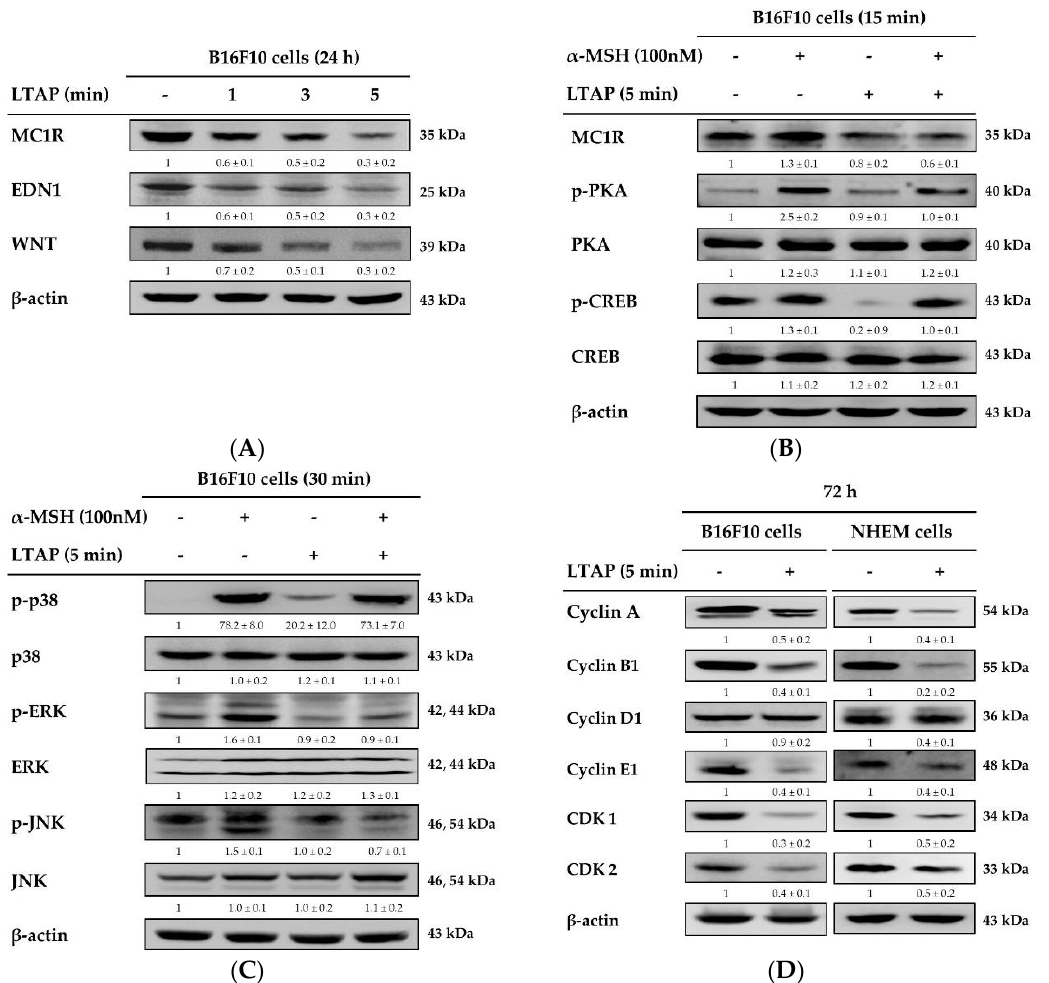
Figure 6. Evaluation of receptors and signals involved in melanogenesis. ( A ) B16F10 cells were exposed to LTAP for 1, 3, or 5 min, and incubated further for 24 h. The protein levels of endothelin 1 (EDN1), melanocortin 1 receptor (MC1R), and Wingless-type protein (WNT) were detected by Western blotting. β -actin was used as a loading control. ( B , C ) Cells were exposed to LTAP for 5 min and incubated for 3 h. Then 100 nM alpha- melanocyte stimulating hormone (α -MSH) was added and incubated for further 24 h and 15 min. Pr otein expression levels of MC1R were determined after 24 h of α -MSH treatment. Phosphorylation of protein kinase A (PKA), cAMP response element-binding protein (CREB) was evaluated after 15 min of α -MSH treatment. Phosphorylation of p38, extracellular signal-regulated kinase (ERK), and c-Jun-N-termi- nal kinase (JNK) was evaluated by Western blotting after 30 min of α -MSH treatment. ( D ) B16F10 cells and NHEMs were